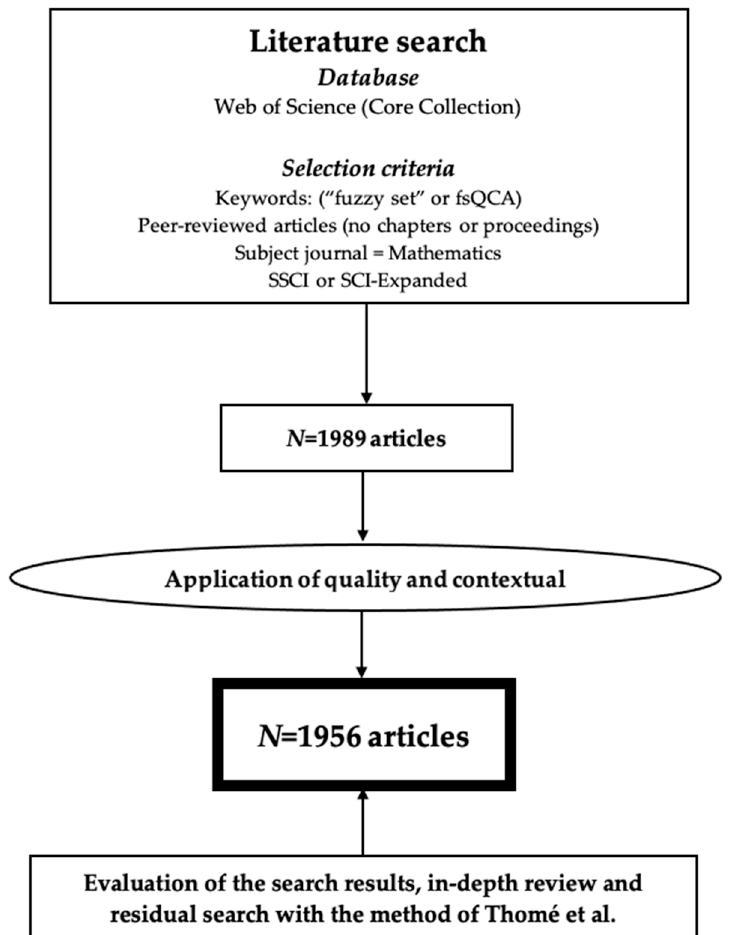
Figure 1. Systematic research approach.